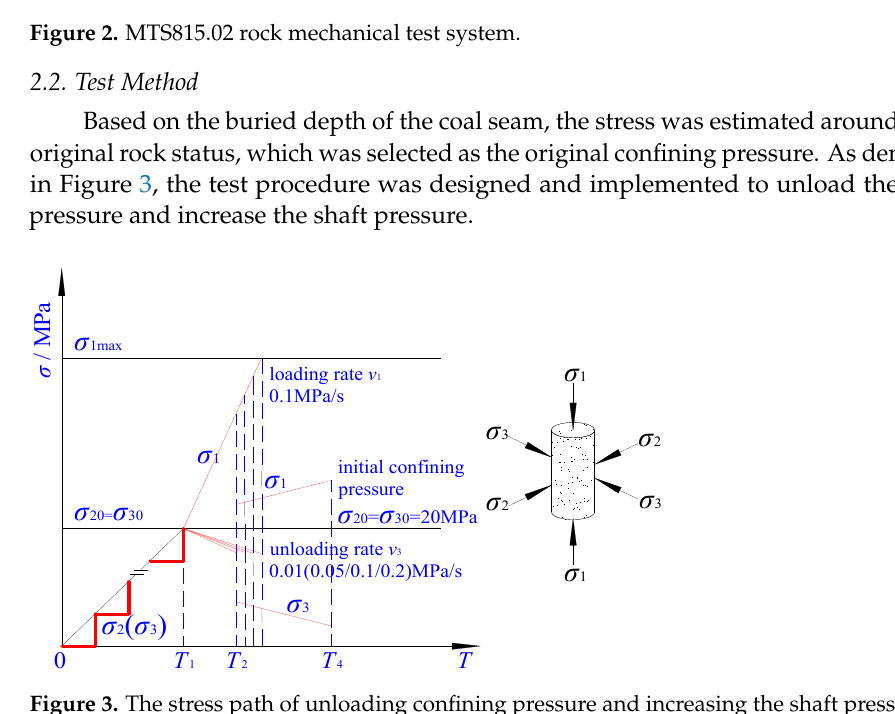
Figure 2. MTS815.02 rock mechanical test system.